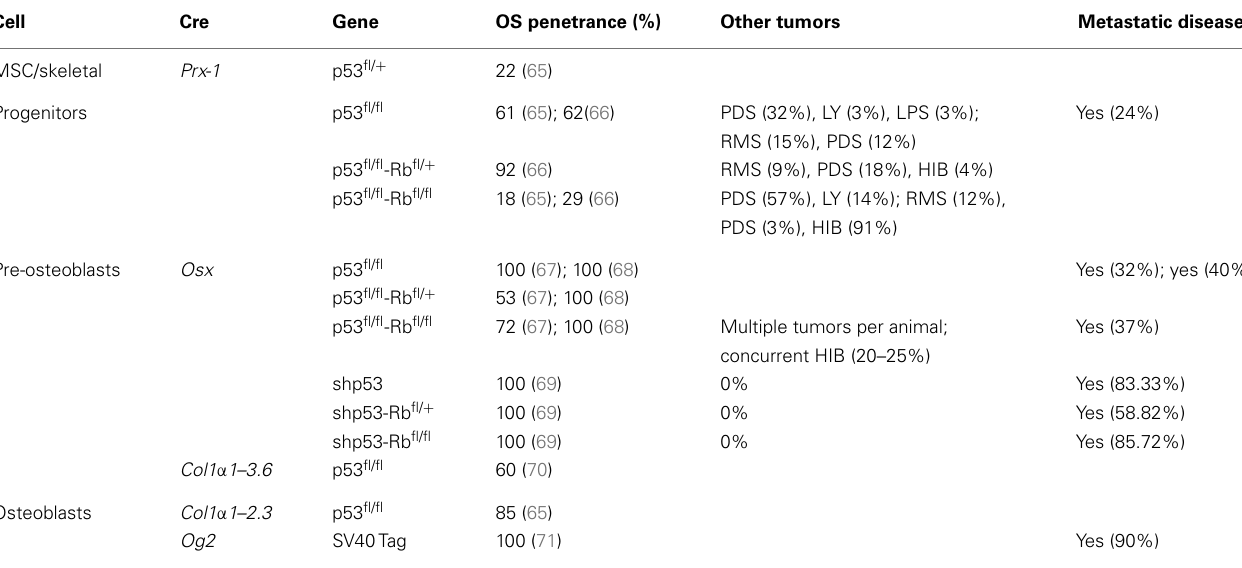
Table 1 | Summary of genetically modified OS murine models